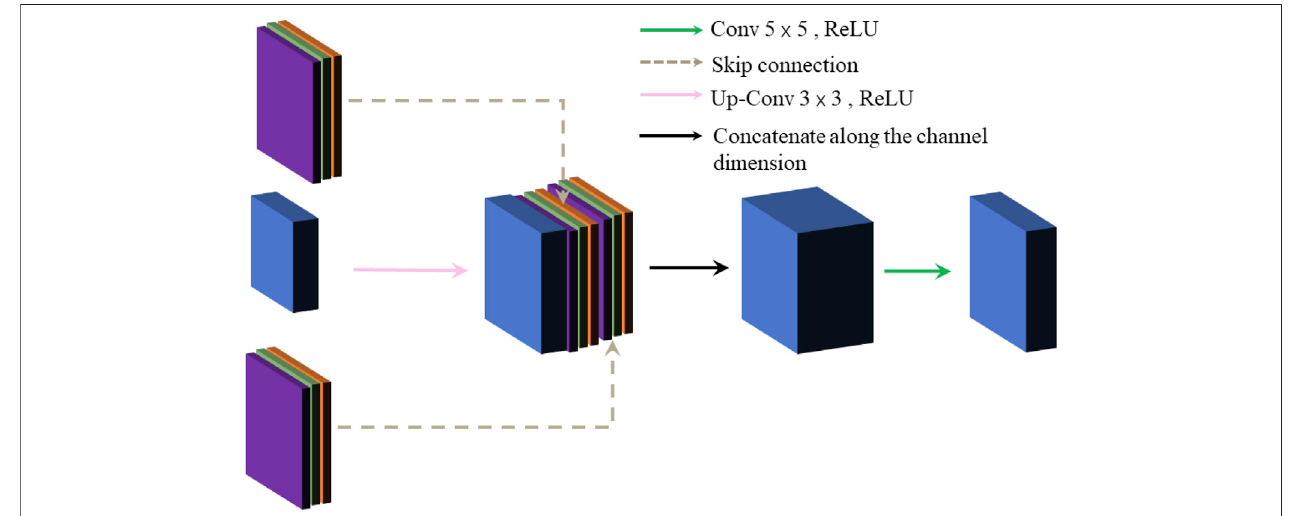
FIGURE 4 | Up-sampling operations and skip connection